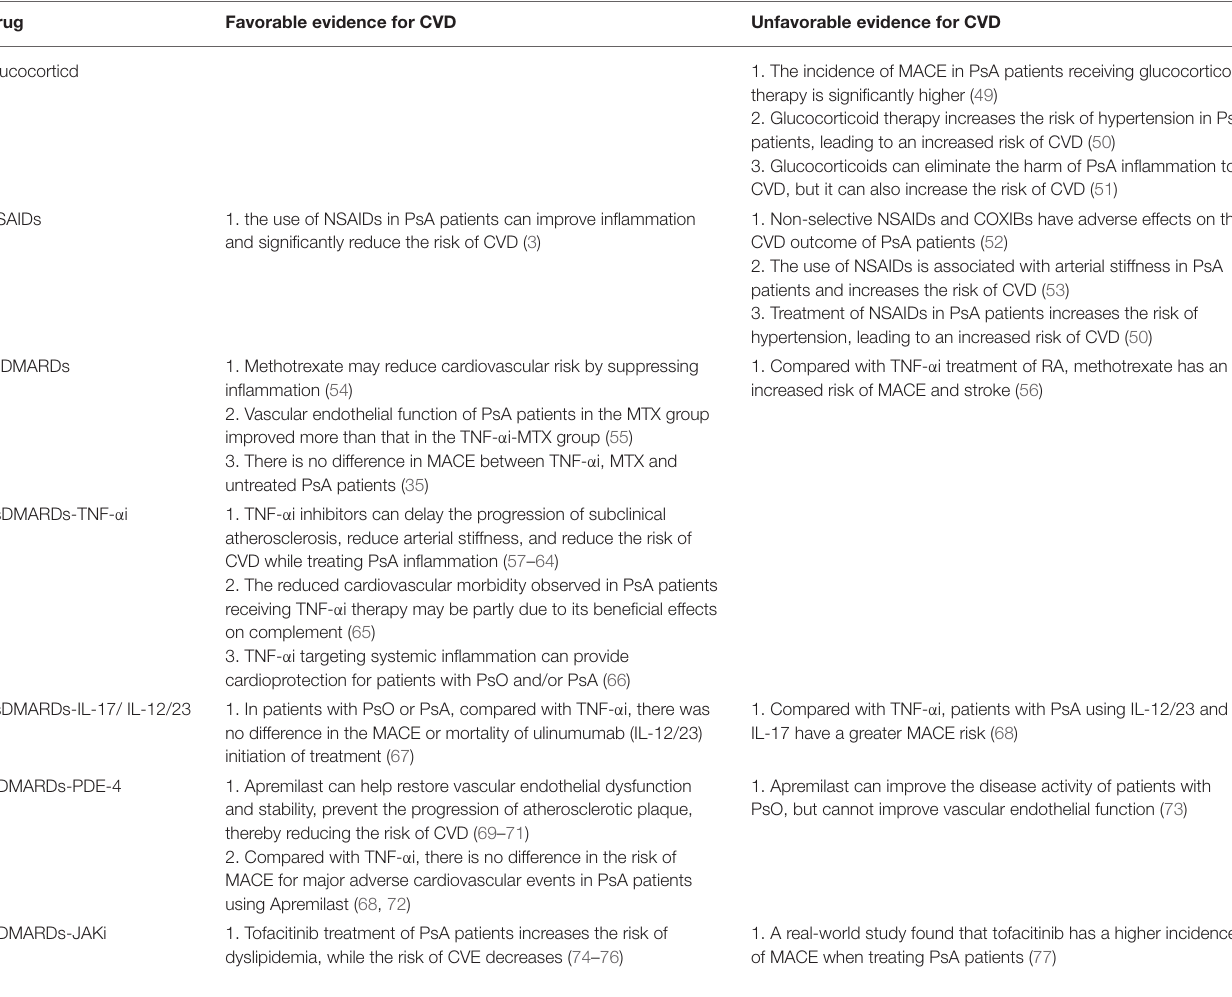
TABLE 2 | Risk of CVD in patients with PsA after drug